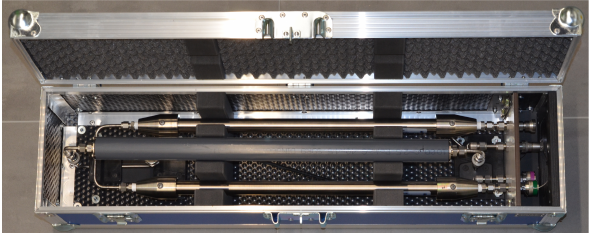
Figure 1. Top: a programmable flask package showing the flasks and the inlet/outlet manifolds. Middle: a schematic showing the Nafion™ dryer system, which is housed inside a custom-built box, and the flow pathway therein. The Nafion™ dryer system is comprised of two Nafion™ dryers (Perma Pure PD-200T-24- MSS), a molecular sieve cartridge, a 2µm in-line filter, and various Swagelok connectors and tubing. Ambient air first passes through the two conditioned Nafion™ dryers connected in series (red line), drying the incoming air. It then goes through the PCP, which pushes the sample through the PFP. The exhaust of the PFP is connected to the molecular sieve cartridge in the NAD, which removes any residual moisture in the air directed into the Nafion™ purge (blue line). The purge flow through the Nafion™ is in a direction op- posite to the flow of the sample air, and the dry purge air ensures that the Nafion™ is able to dry at least 230L of sample air that flows through the system during a typical flight sampling. Bot- tom: picture of the Nafion™ air dryer in a custom-built casing (90 . 5 × 23 . 5 ×